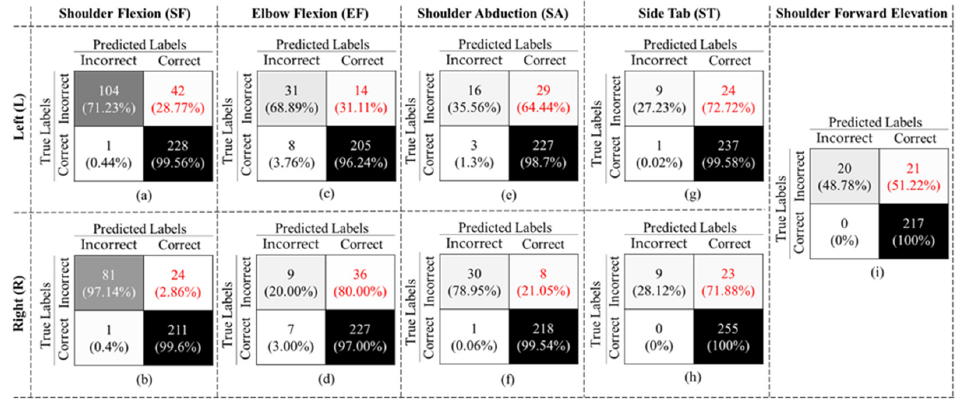
Figure 9. Confusion matrix for models ( a ) SFL, ( b ) EFL, ( c ) SAL, ( d ) SFR, ( e ) EFR, ( f ) SAR, ( g ) STL, ( h ) STR, and ( i ) SFE obtained using 10-Fold cross validation. ( h ) STR, and ( i ) SFE obtained using 10-Fold cross